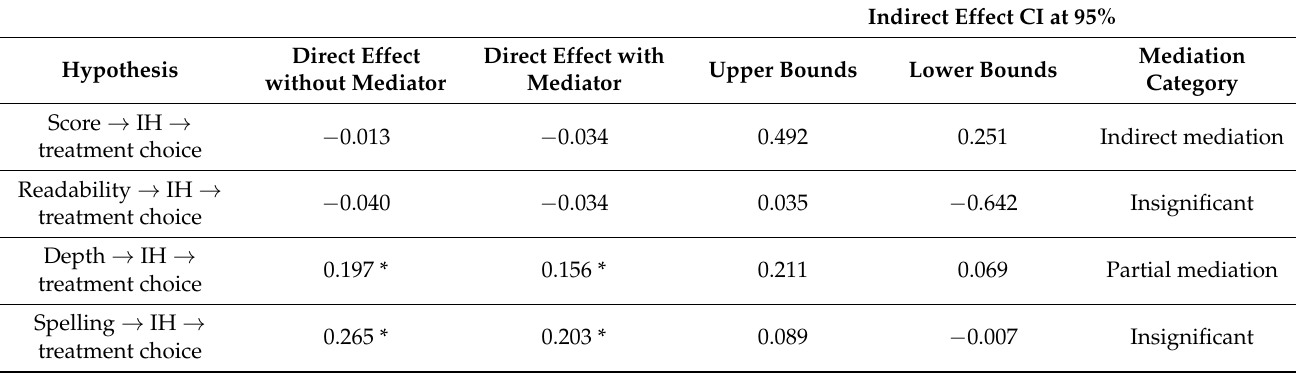
Table 5. Bootstrapped mediation analysis